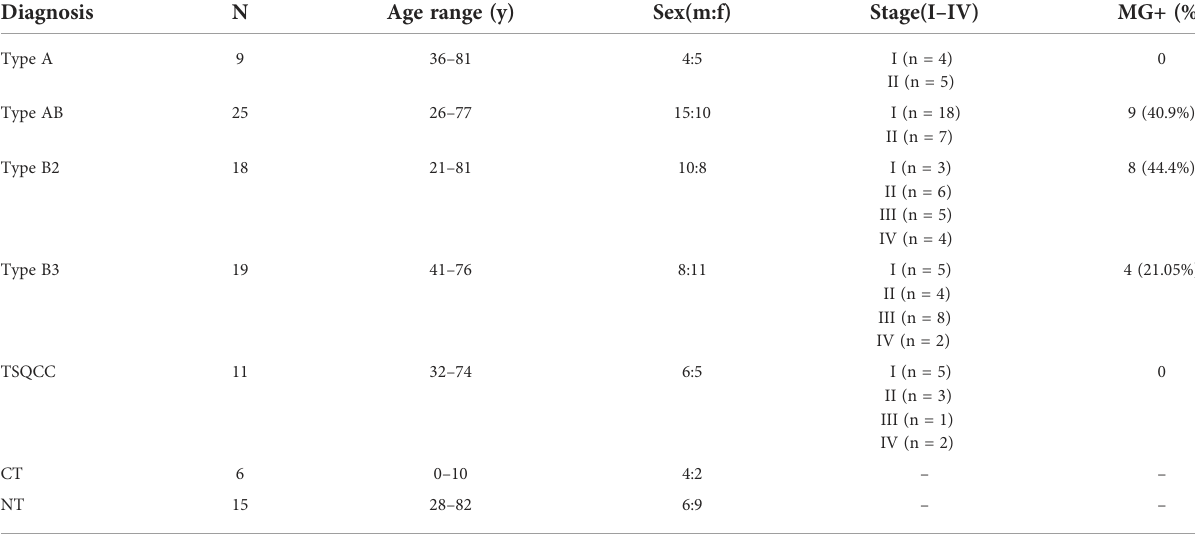
TABLE 1 Characteristics of the thymoma and thymic carcinoma patients and non-neoplastic adult and pediatric control from cardiac surgery patients studied for WNT ligands, frizzled receptors and WNT inhibitors.